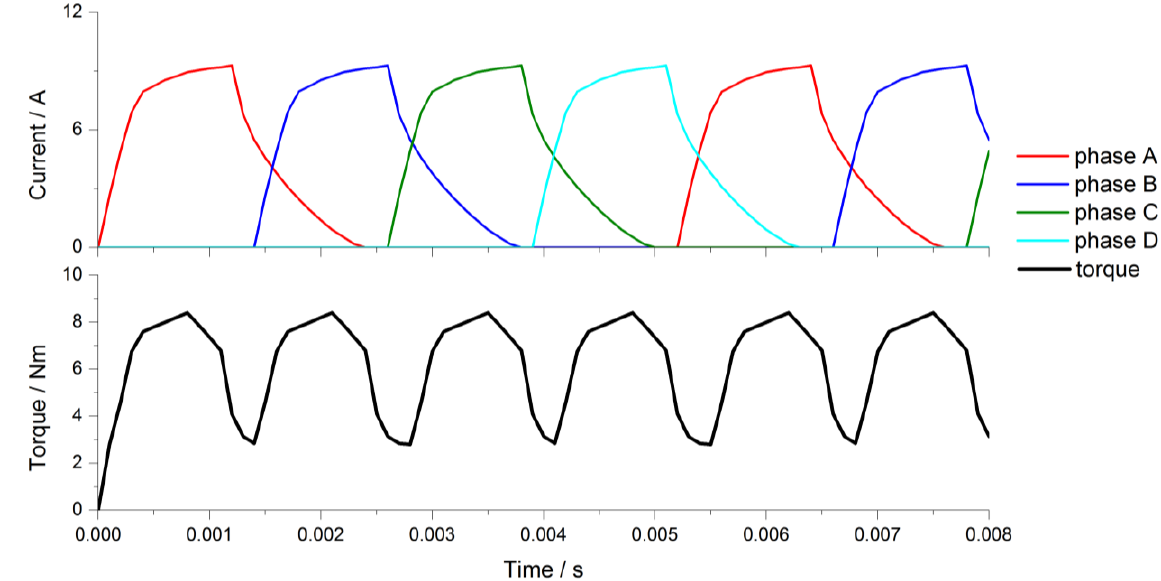
Figure 15. The current and torque waveforms of inner